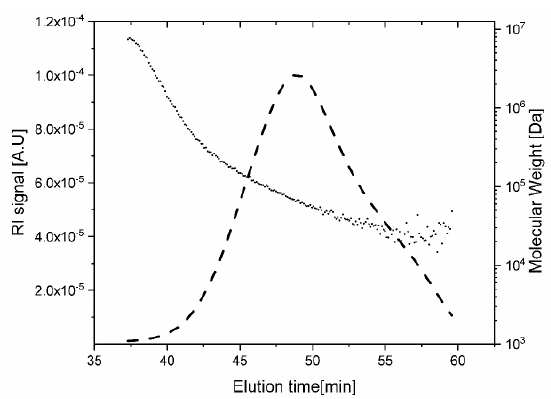
Figure 2. SEC elution profile of cellulose acetate dissolved in water (0.1 M NaNO 3 ). Dashed line—RI signal (axis at left); dotted line molecular weight (axis at right).